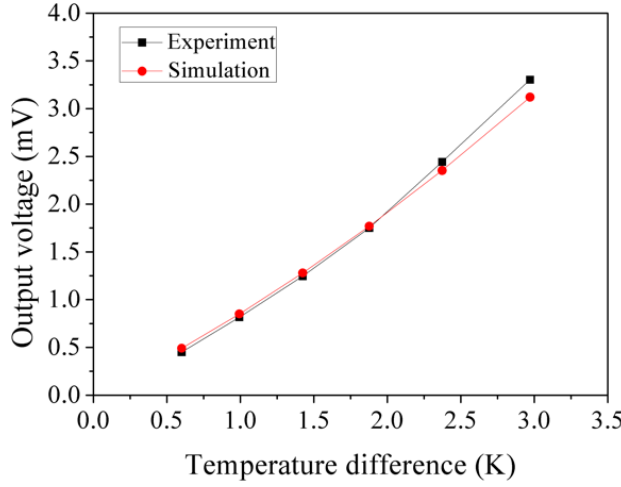
Figure 14. Measured OV of the microgenerator.